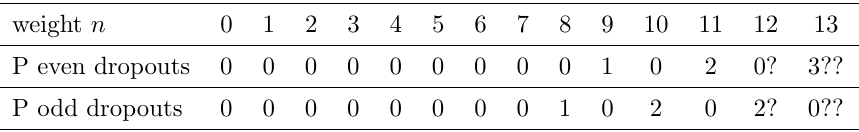
Table 10 . The number of dropouts: functions that do not appear in H hex even though they satisfy all the constraints at symbol level. The numbers at weights 12 and 13 are slightly uncertain.